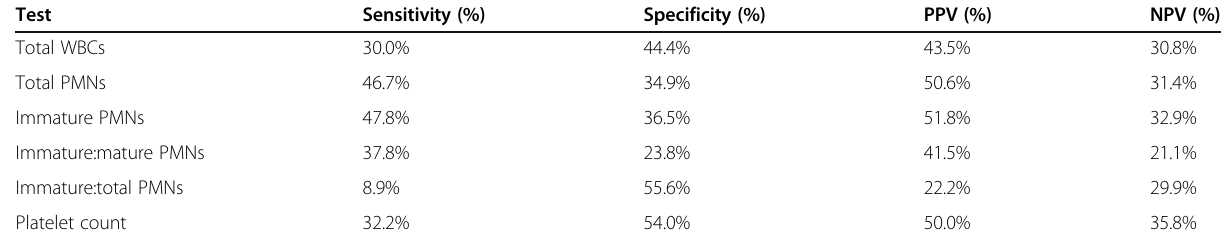
Table 7 Diagnostic performance of individual items of HSS for diagnosis of late-onset sepsis